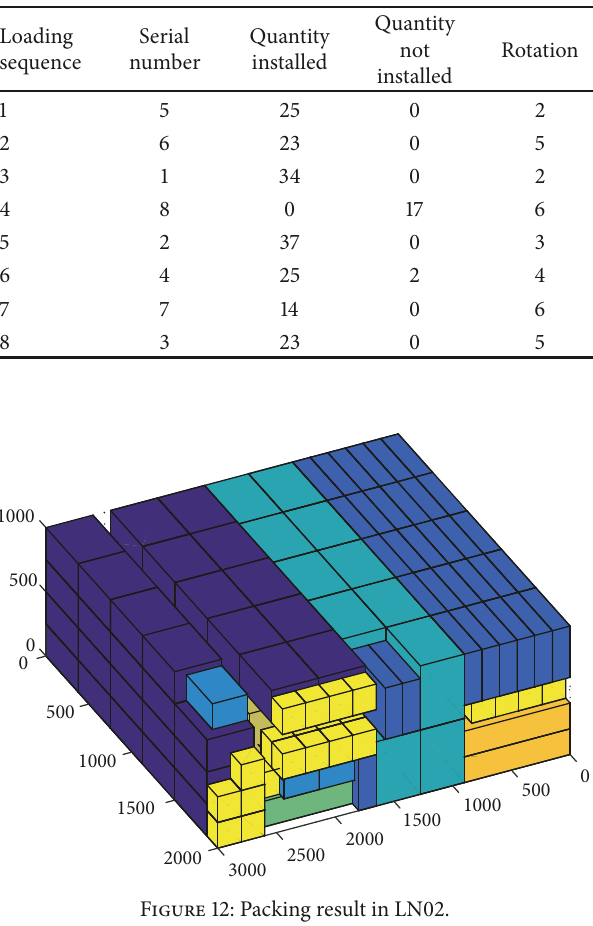
Table 4: Test result in LN06.